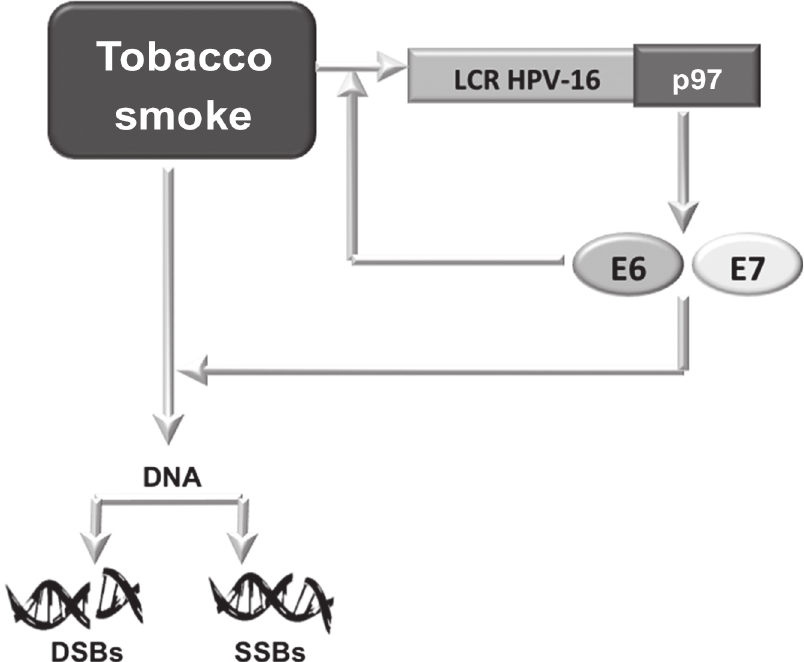
Fig 6. A model of interaction between CSC and HPV in lung cells is suggested. CSC is able to induce the activity of the p97 promoter in the context of high-risk HPV LCR conducting to E6 and E7 transcripts expression. The high-risk E6 and E7 oncoproteins sensitize lung cells for tobacco smoke-associated oxidative DNA damage and collaborate with tobacco smoke for p97 promoter